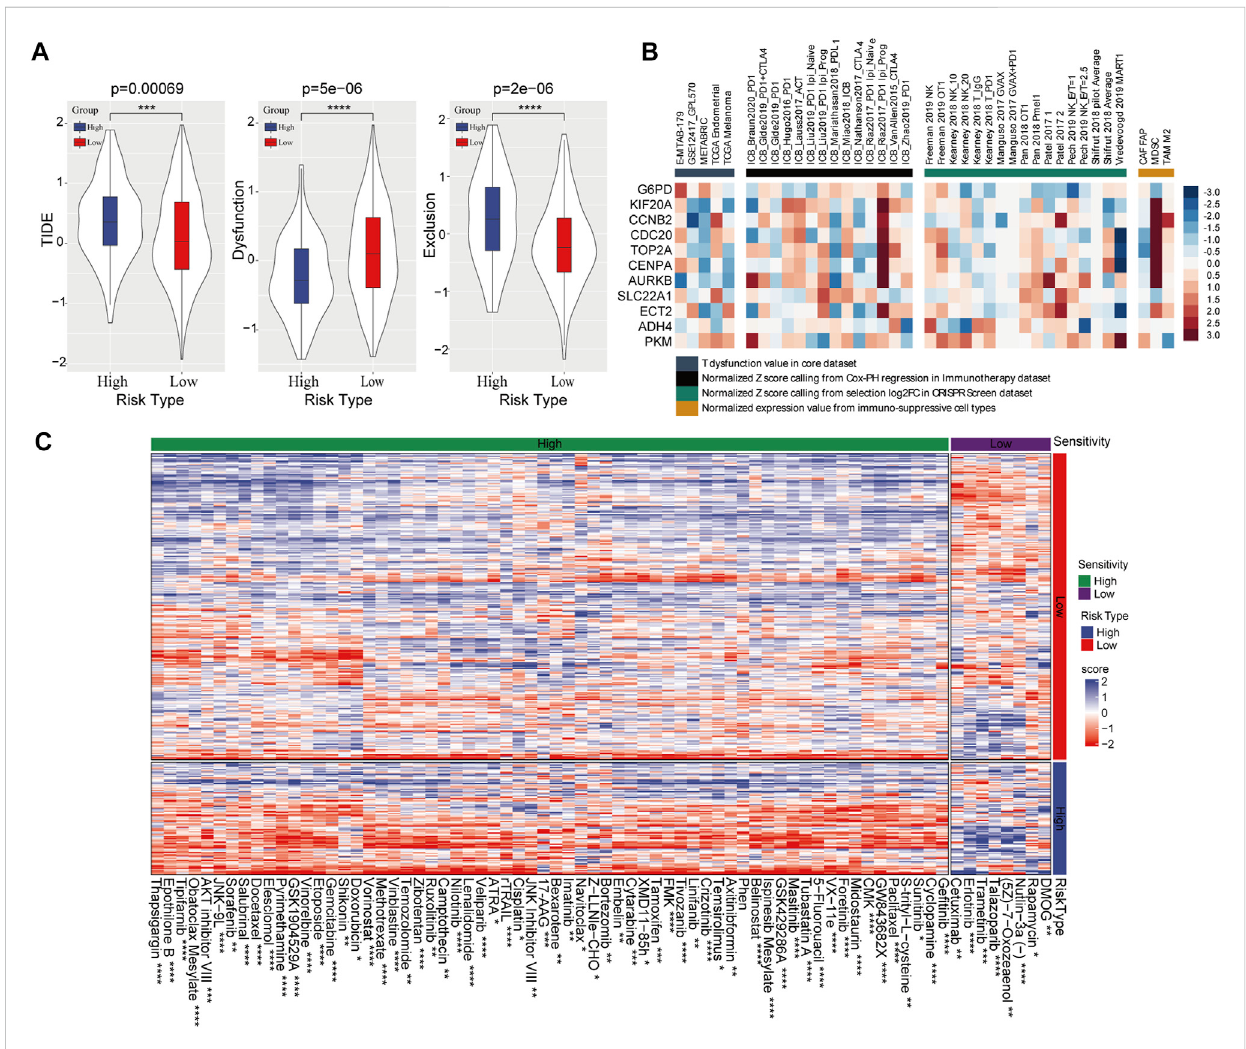
FIGURE 6 Effect of theprognostic risk model on immune response and drug sensitivity. (A) Comparison ofTIDE score, T-cell dysfunction and T-cell exclusion scores in high- and low-risk group. (B) The correlation between 11 PRMT-related risk genes and T-cell dysfunction, ICB response and phenotypes in genetic screens and immune suppressive cell types. (C) Sensitivity of 72 chemotherapeutic drugs in high-risk and low-risk